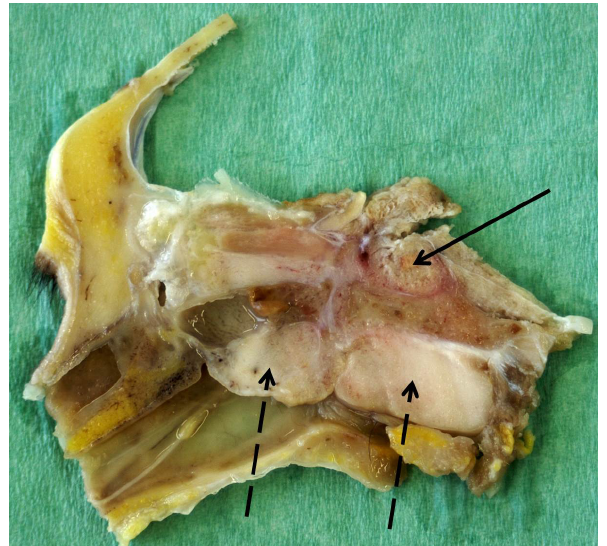
Figure 2. Median cross section through the formalin-fixed skull of an old pig-tailed macaque (brain and tip of the nose removed): meningioma in the hypophyseal fossa (black arrow) and in the pha- ryngeal area (dashed